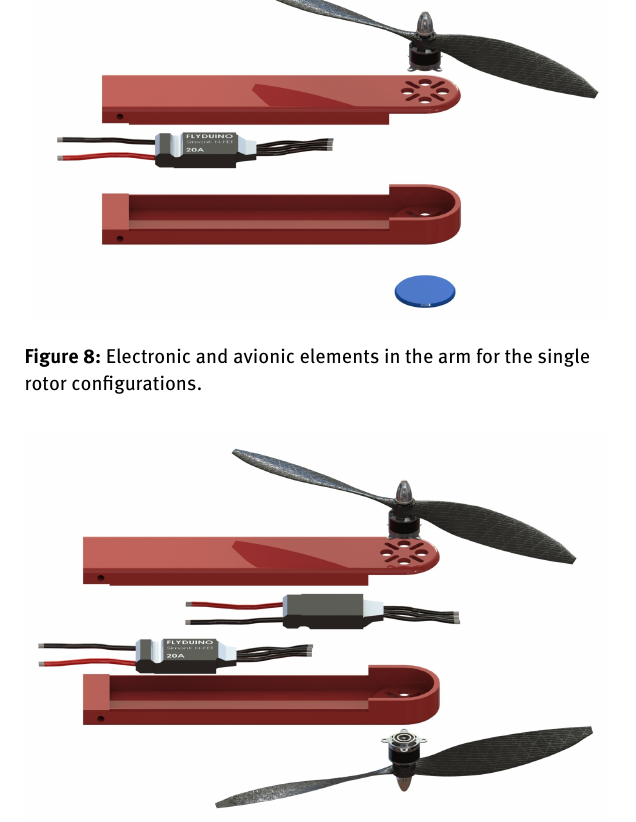
Figure 9: Electronic and avionic elements in the arm for the double rotor configurations.